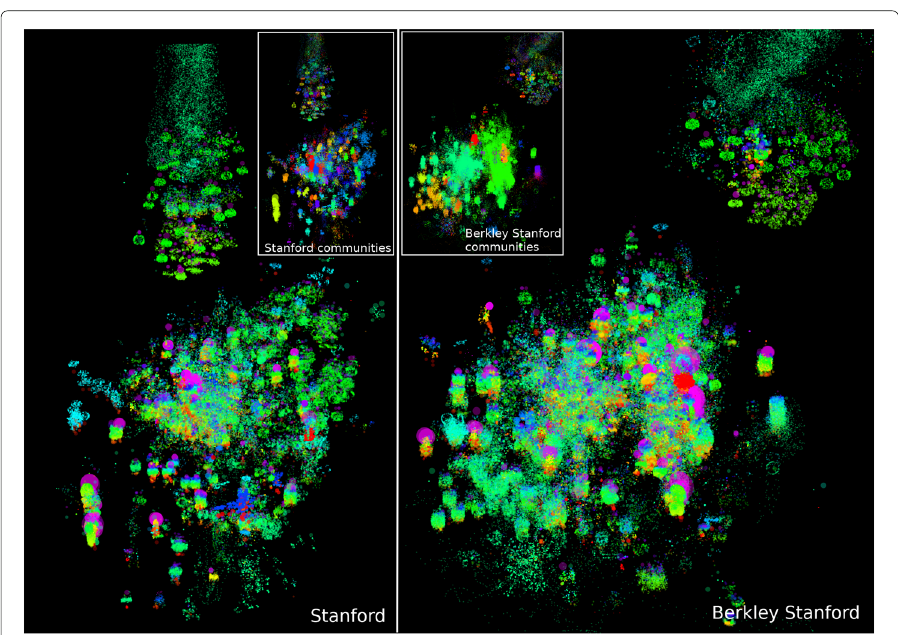
Fig. 7 Bow-tie locality of Stanford (left) and Berkeley-Stanford (right) data. Colored to incoming link share, from high to low in purple, blue, green, yellow and red like Fig. 5. Community detection results are shown in the upper corner inset